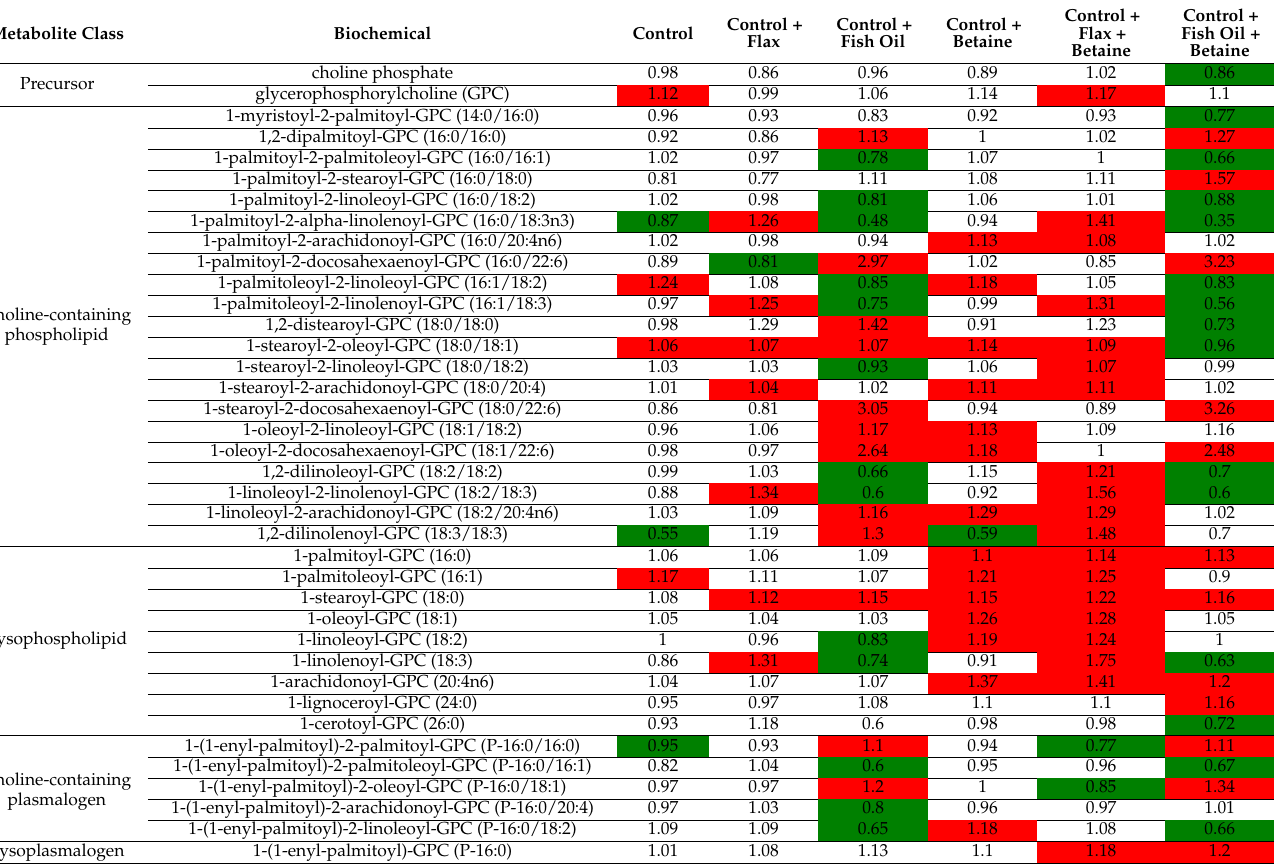
Table 8. Choline-containing phospholipids which changed during the study while consuming control, or betaine, flax, and fish oil supplemented foods